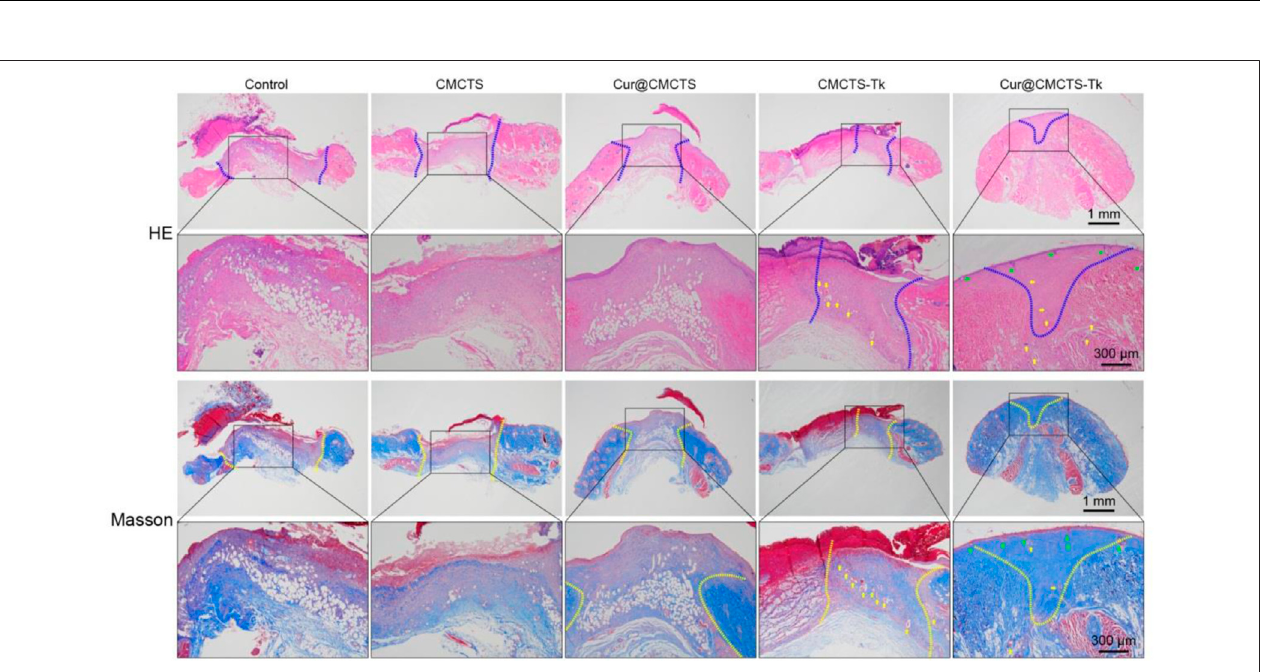
Frontiers in Pharmacology |